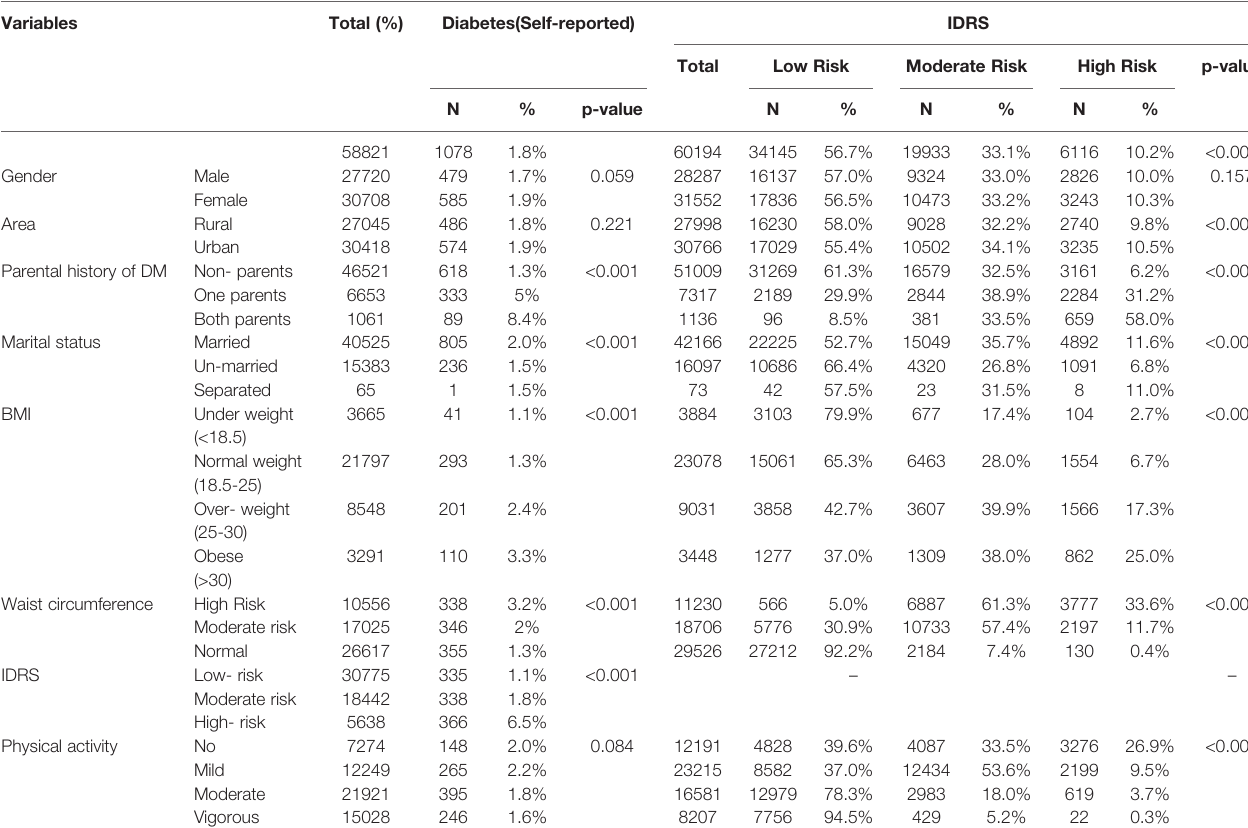
TABLE 1 | Frequency distribution of diabetes participants (self-reported) with context to gender, anthropometric parameters, and different geographical locations in India. Variables Total (%)